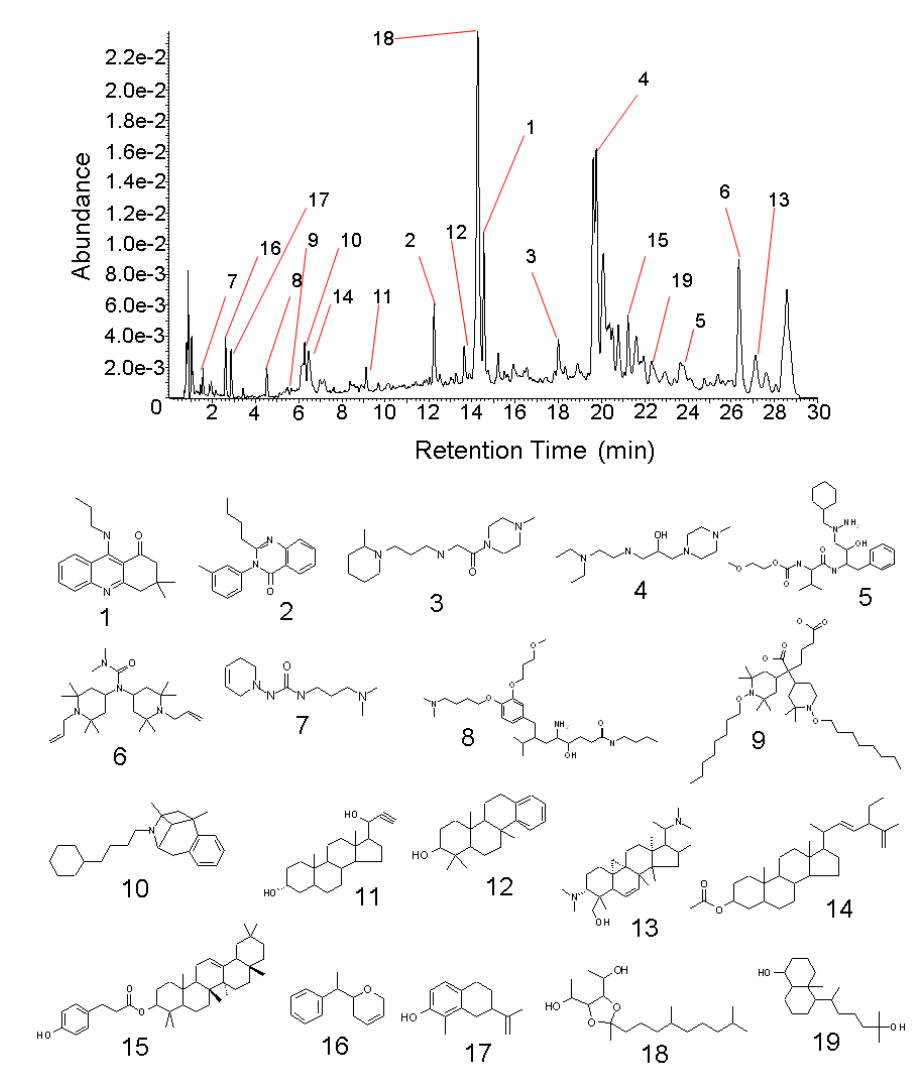
Figure 2. UPLC profile and compounds proposed from the active